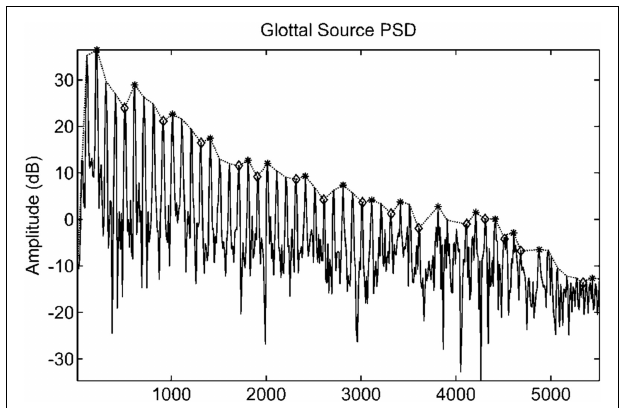
FIGURE 3 | Power spectral density of the glottal source evaluated over a temporal window which includes multiple glottal cycles . The relative maxima of the distribution are marked by the harmonics present in the signal. The interconnection of these maxima is known as harmonic envelope or power spectral density